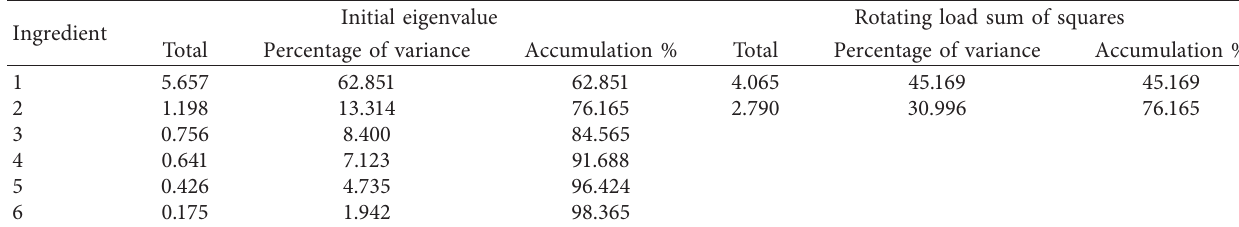
Table 2: Explanation of total variance.